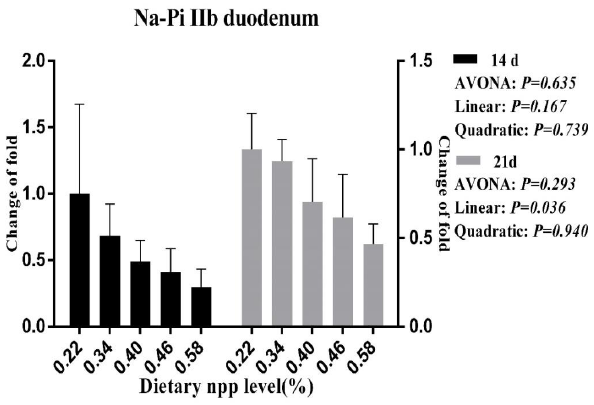
Figure 1. Effect of dietary non-phytate phosphorous levels on NaPi-IIb gene expression in duodenum of ducks at 14 d and 21 d of age. NaPi-IIb, type IIb sodium-phosphate cotransporter; npp, non-phytate phosphorous.